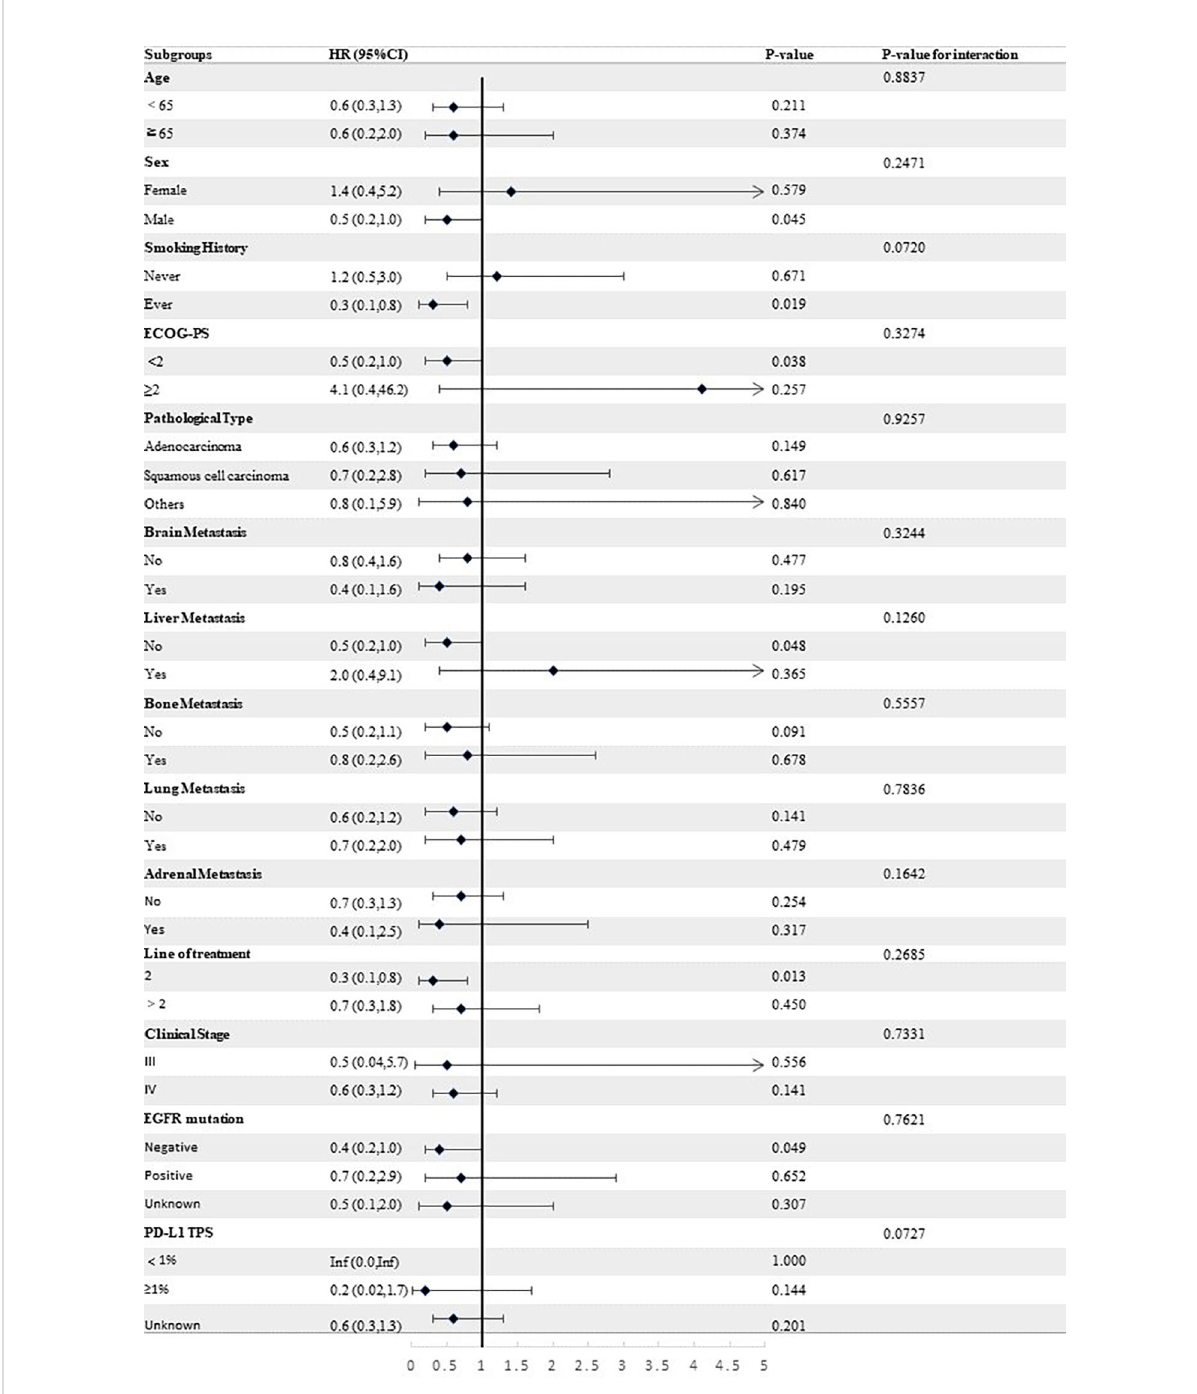
FIGURE 5 Forest plot of risk of disease progression for patients in PAC group compared to PC group in different